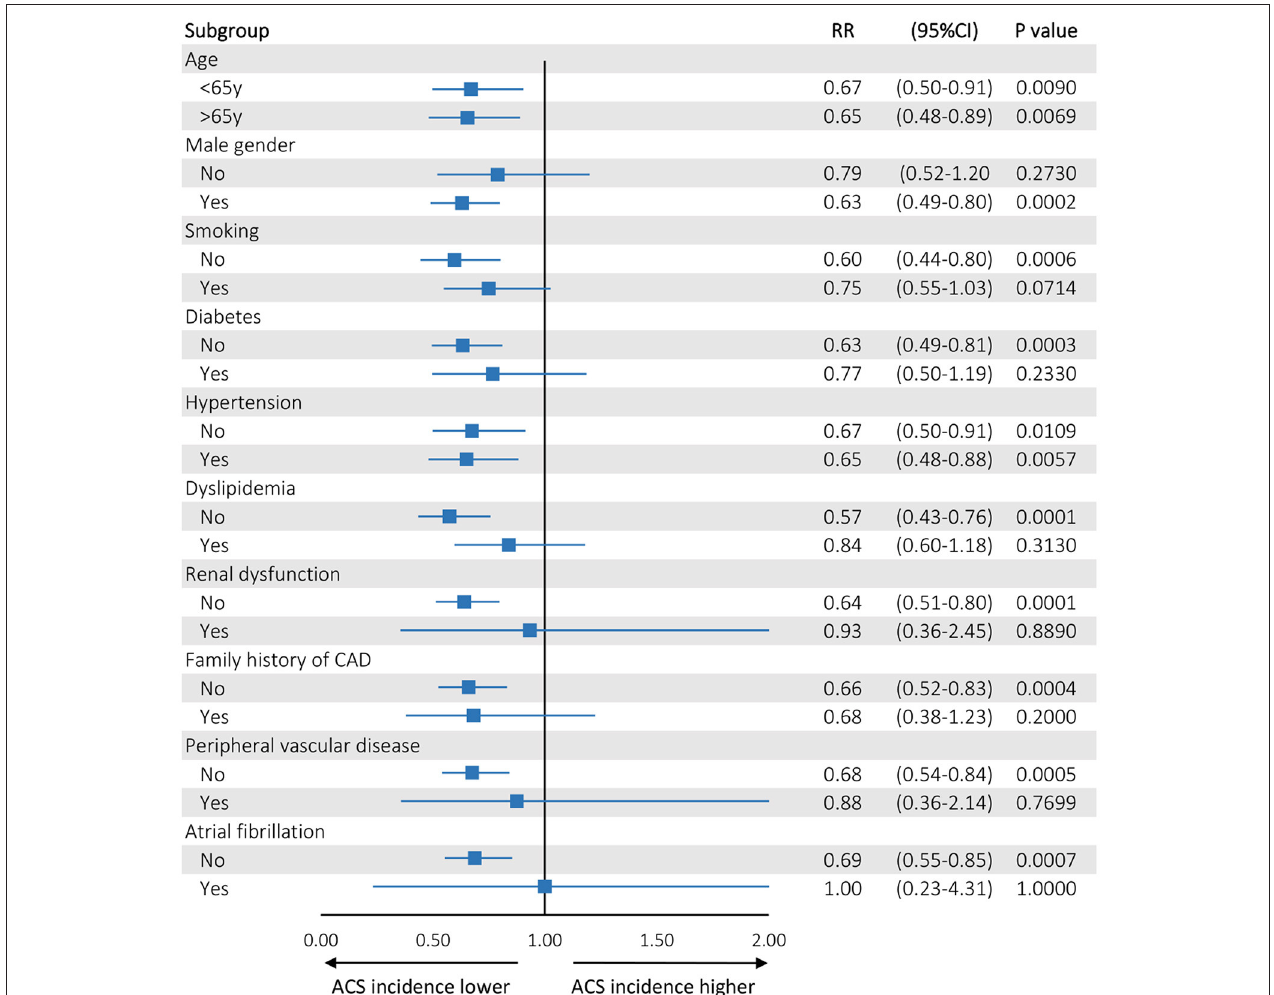
FIGURE 2 | Forest plot showing the results (Risk Ratios) of regression analysis of the weekly incidence of ACS across different strata of registered patient characteristics. Age was dichotomized at its median value (65 years)—rest of the remaining categorical explanatory variables were stratified by factor (GLM with a Poisson log-likelihood function). Statistical significance was assumed for P < 0.001 to account for multiple testing.